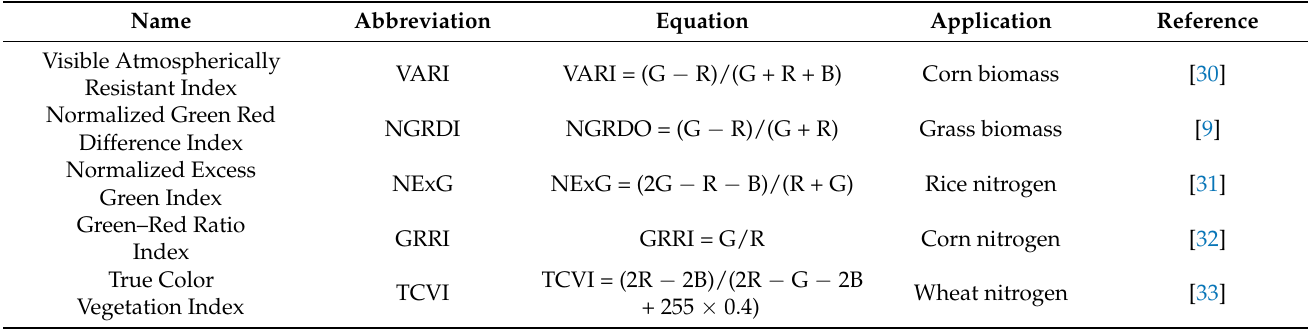
Table 1. Vegetation indices from the literature used in this